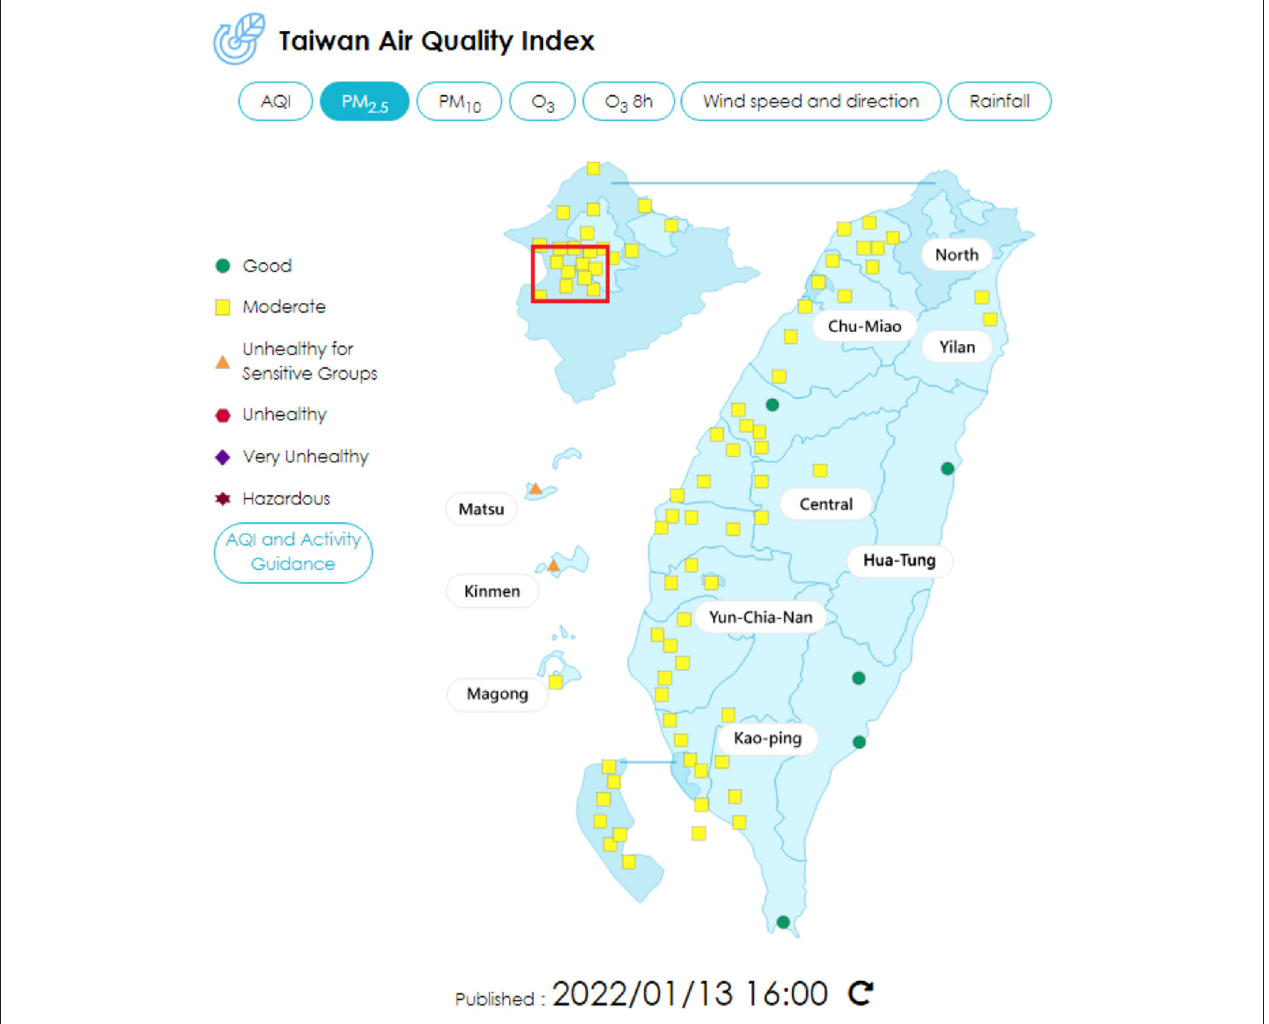
FIGURE 2 | Air quality index of PM2.5 distribution in Taiwan, using the data on January 13, 2022 for example. The red block shows the areas involved in this study